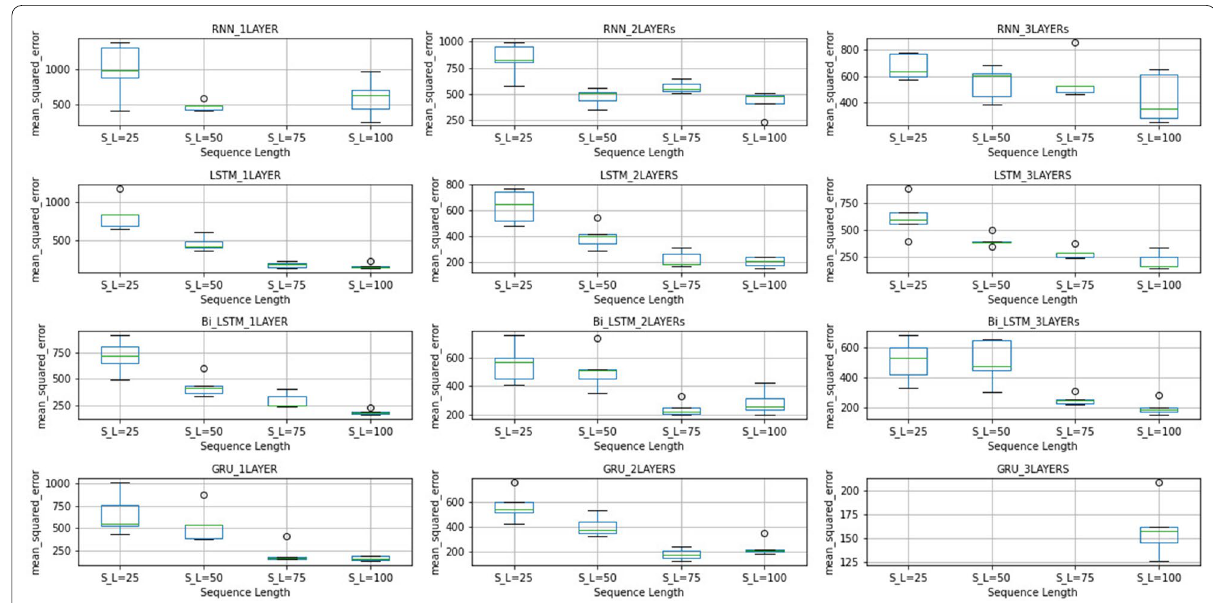
Figure 8 Performance of different sequence length on the test